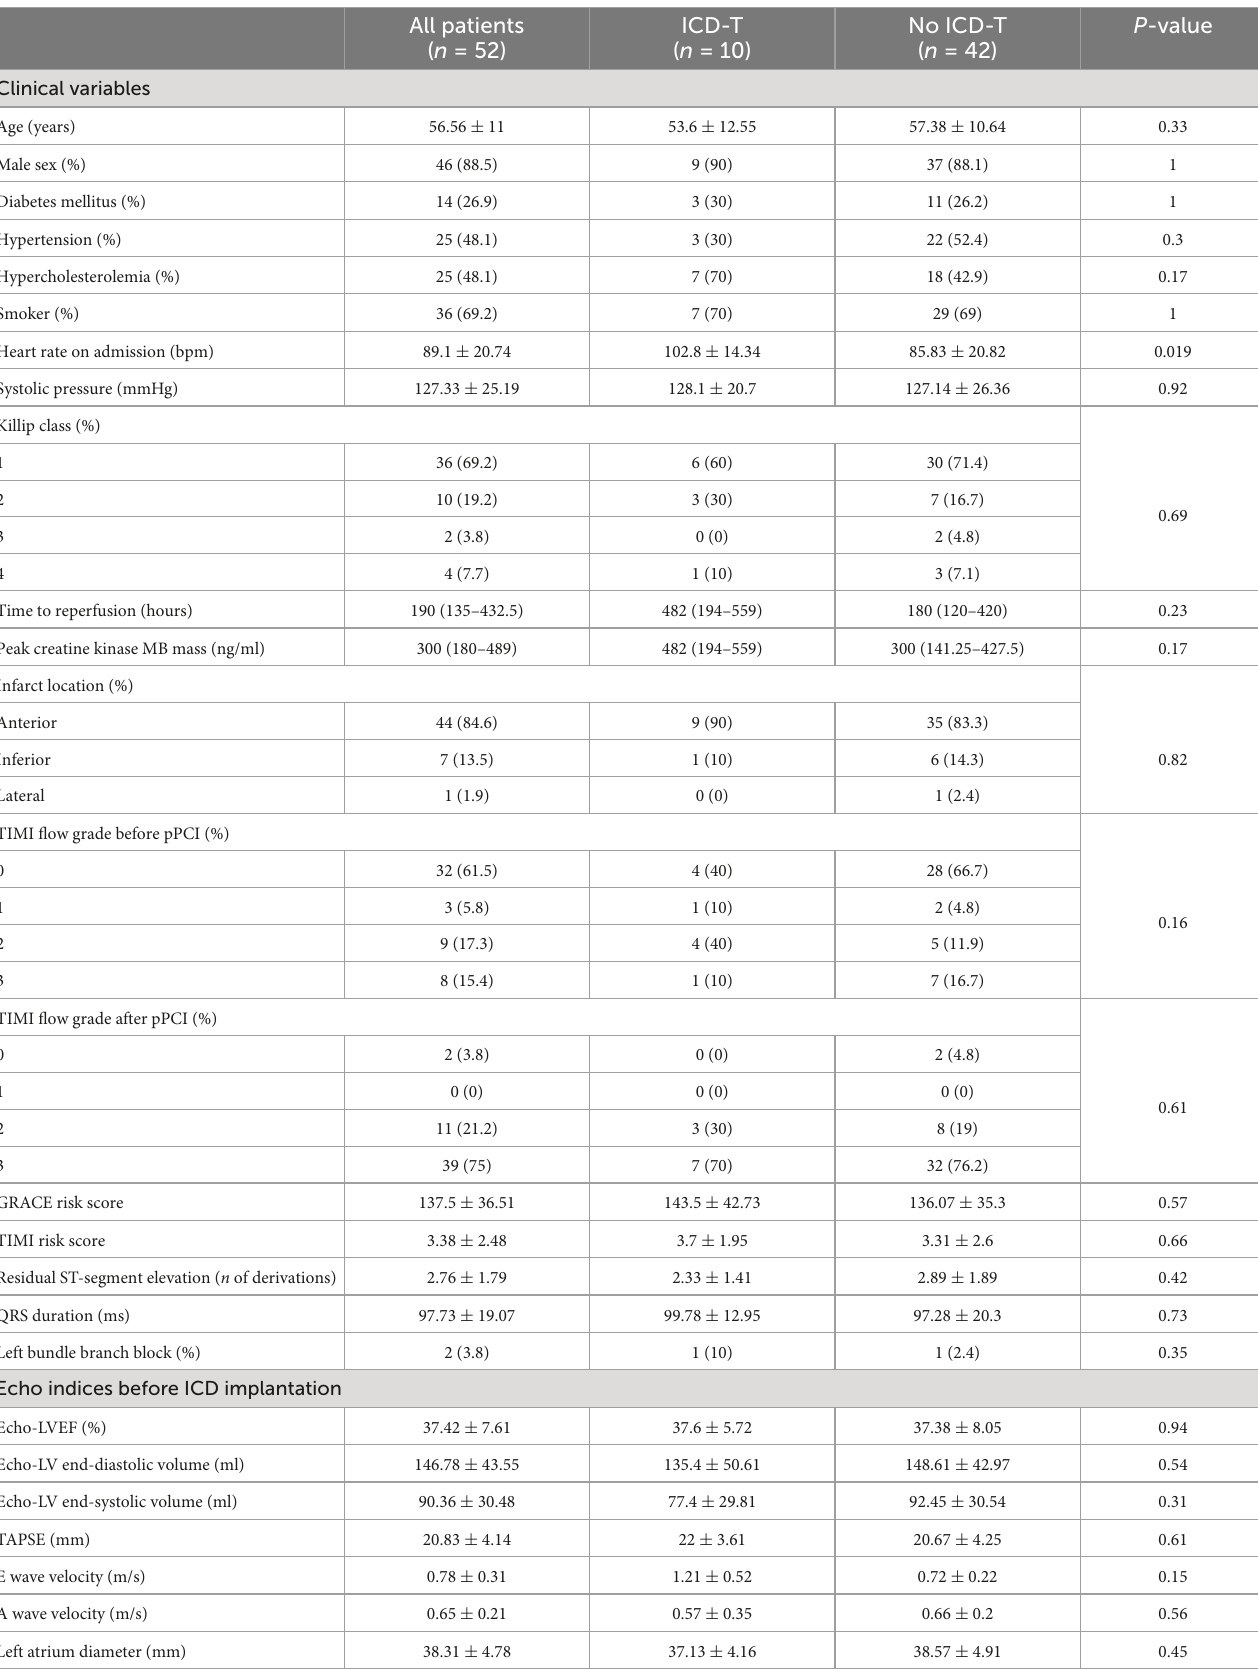
TABLE 1 Baseline, Echo, and CMR characteristics of the entire cohort and of patients with and without ICD-T.